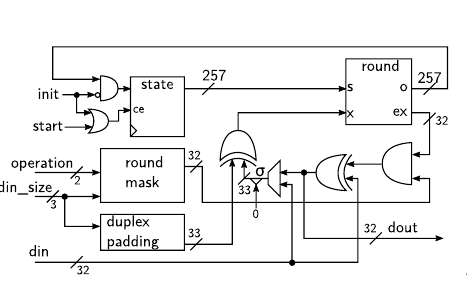
Figure 4: Subterranean single-round du- plex logic.